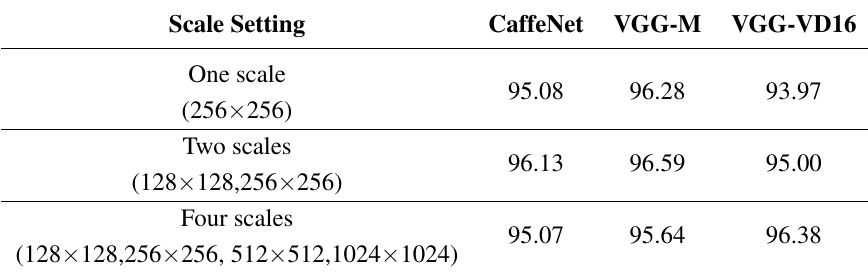
Table 5. Classification Accuracy on the UCM Dataset of Dense CNN Features under Different Scale Settings.